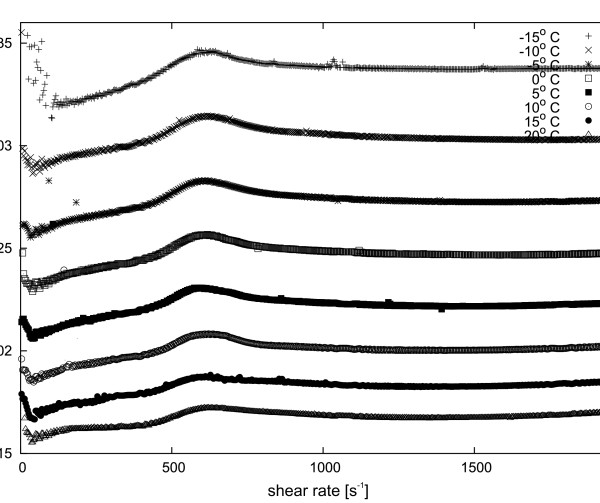
Dynamic viscosity dependence of 15 wt. % Y2O3nanopowder suspension in ethyl alcohol at various temperatures.